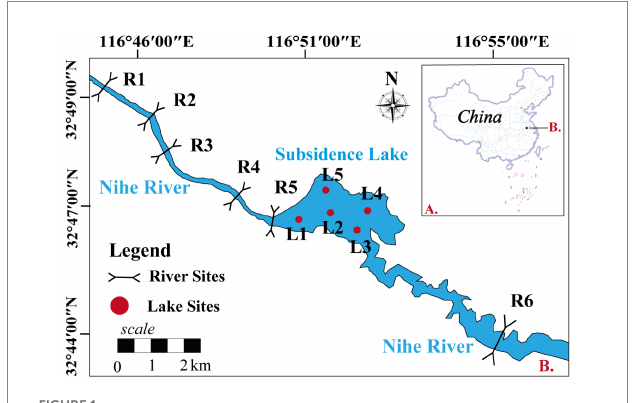
FIGURE 1 The sites of water samples obtained in the subsidence